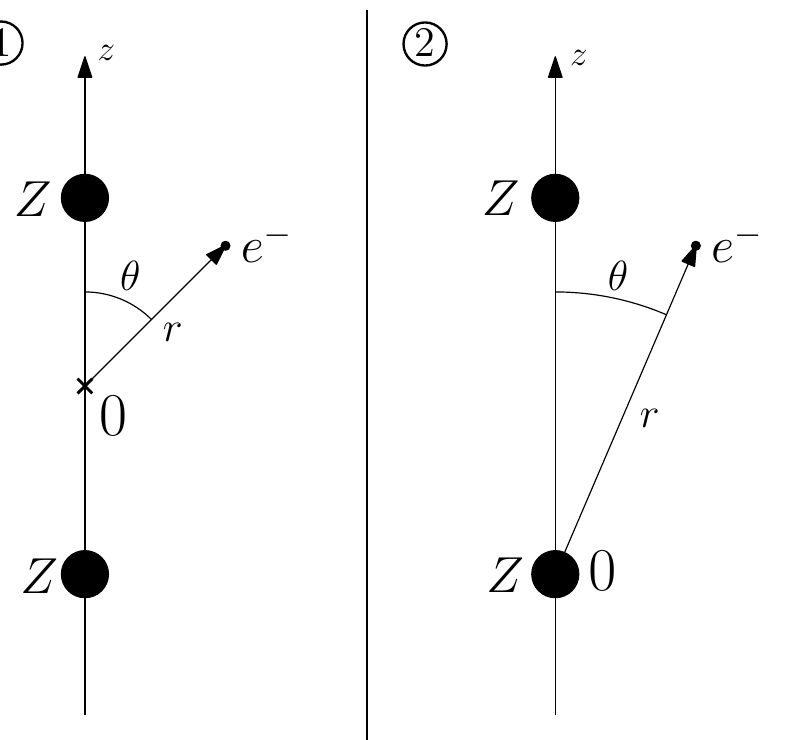
Figure 4. Two different coordinate systems considered. Left: ( 1 ) the origin is at the center-of-mass of the system; right: ( 2 ) the origin is at the center of one of the